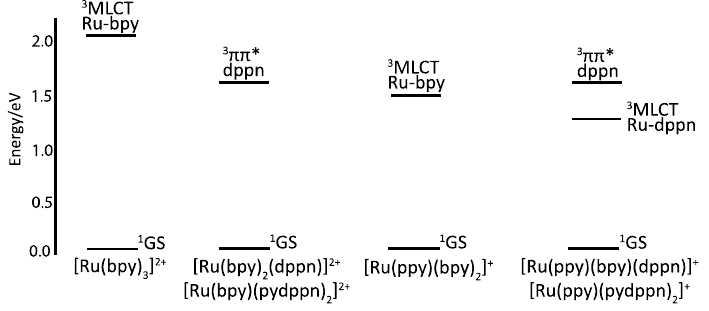
Figure 18. Relative energies of the low-lying triplet states of ruthenium II complexes bearing dppn, bpy and ppy ligands [119].